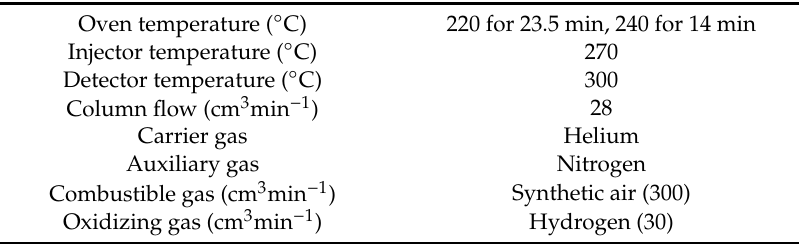
Table 3. Chromatography conditions for fatty acid methyl ester (FAME) determination.